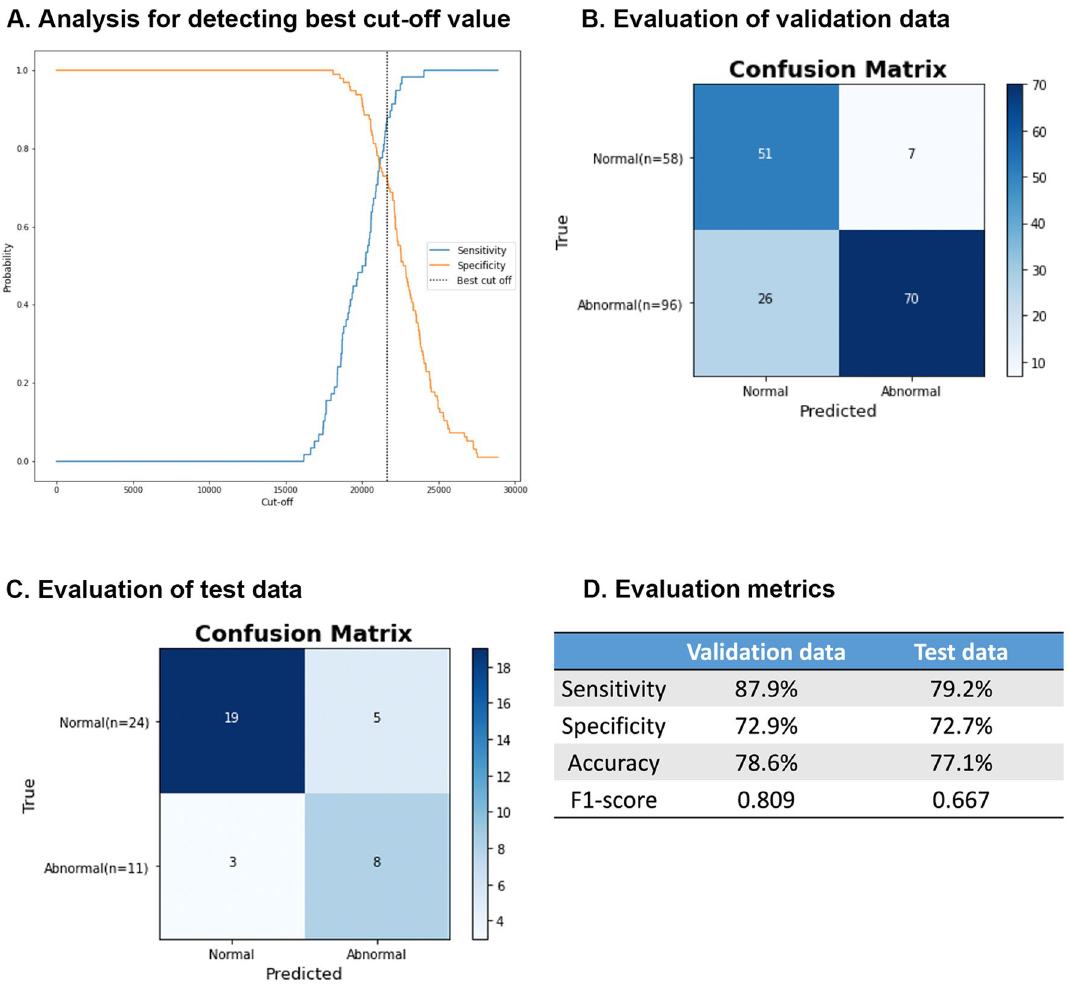
Figure 3. ( A ) Analysis for determining the best cut-off value using receiver operating characteristic (ROC) curve analysis. The best cut-off value was 21,636. ( B ) Confusion matrix between true and predicted validation CT images according to the best cut-off value. ( C ) Confusion matrix between true and predicted test CT images using the same best cut-off value. ( D ) The sensitivity, specificity, accuracy, and F1-score values of validation and test data were